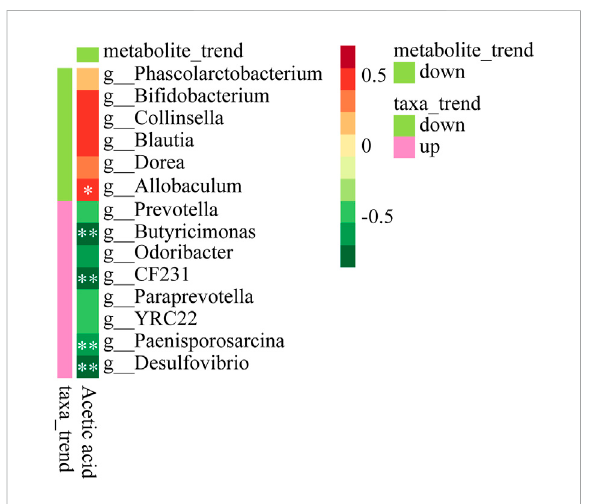
FIGURE 8 Heat map to show Spearman ’ s correlation between Acetic acid and microbiota composition at the genus